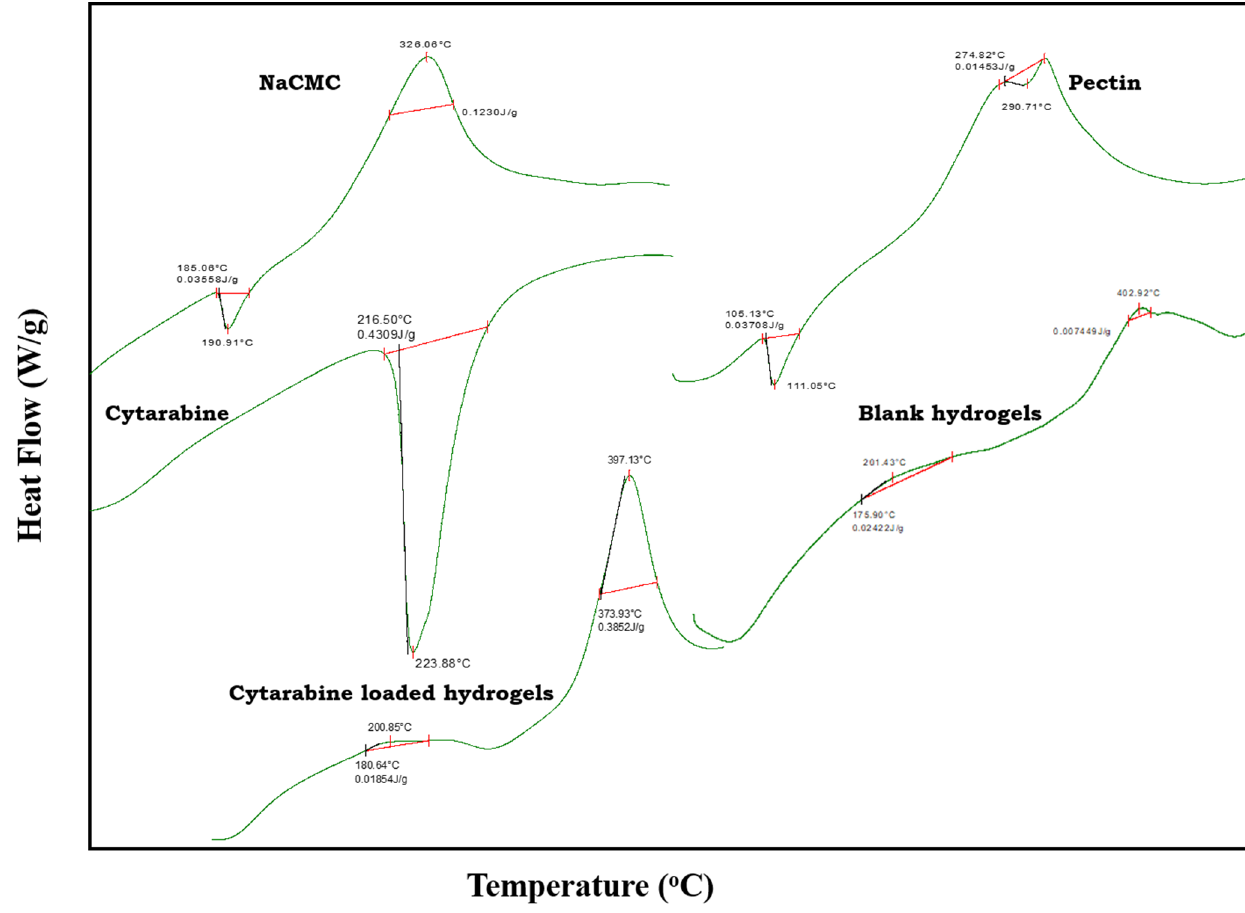
Figure 3. DSC thermograms of Na-CMC, pectin, cytarabine, blank hydrogel, and cytarabine-loaded hydrogel .